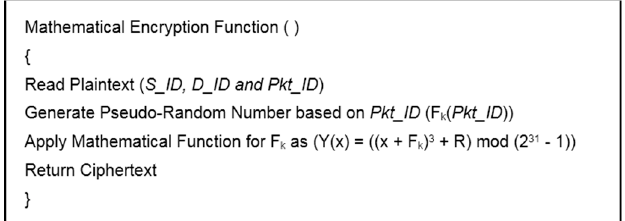
Figure 3. Encryption with authentication.